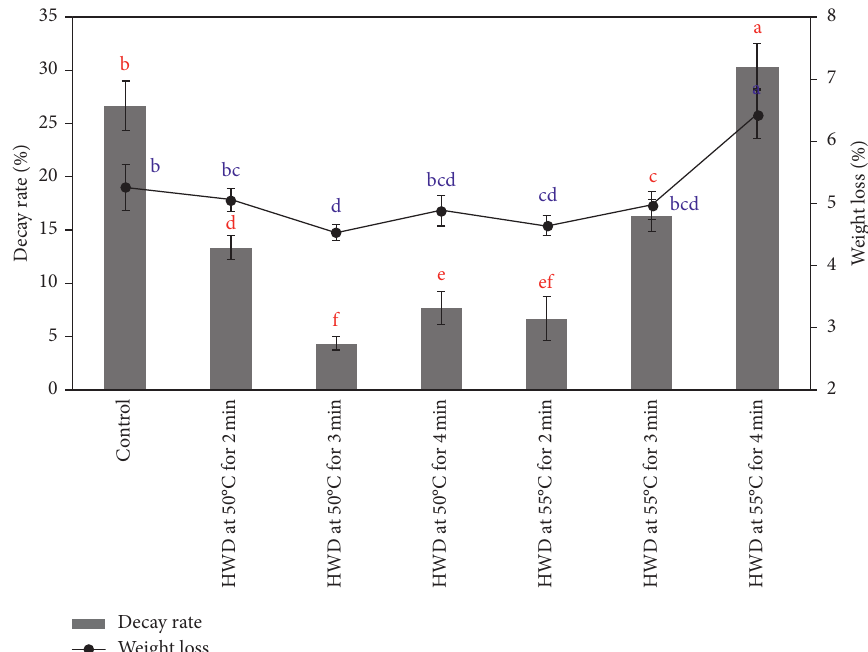
Figure 1: Effect of different HWD treatments on decay rate and weight loss of “Nanfeng” mandarin stored at 6 ± 0.5 ° C for 90 days. Values are the mean ±